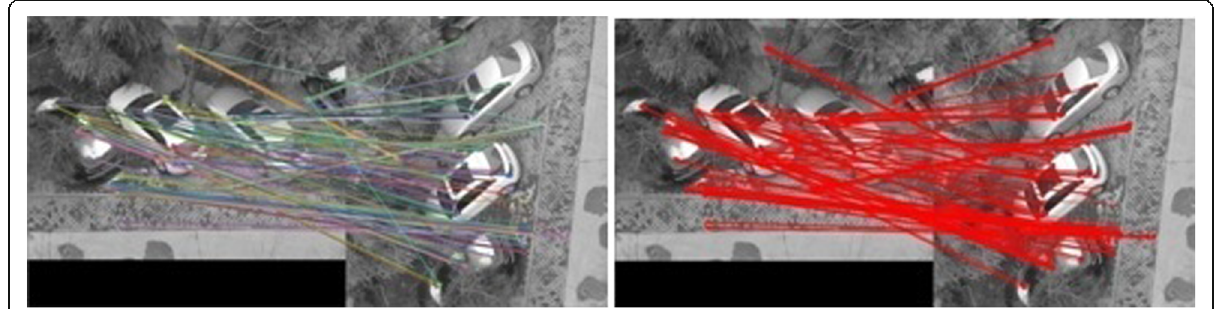
Fig. 34 Comparison of the effects before and after filtering the mismatch